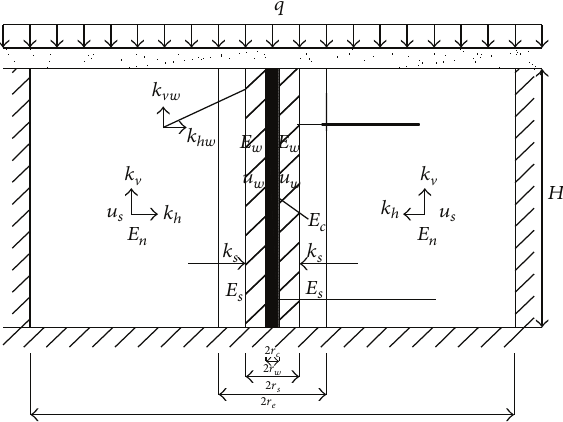
Figure 2: Computing model of single CCSG